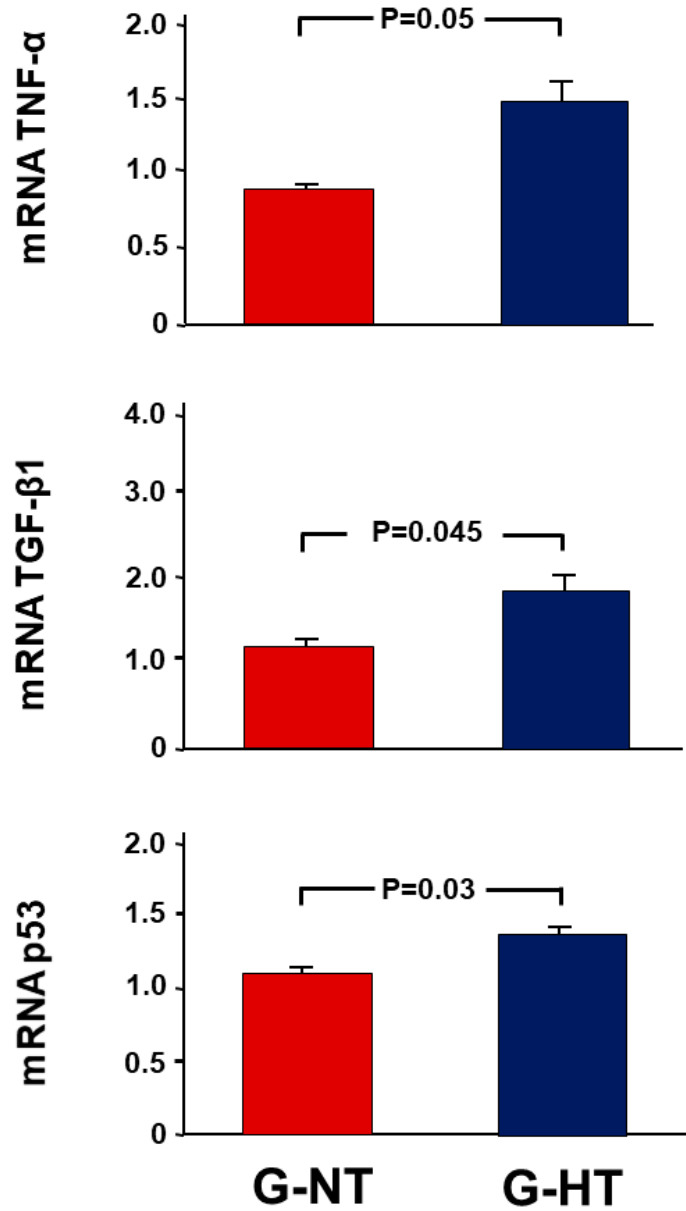
Figure 3. The fold-expression of the gene expression of pro-inflammatory (TNF- α ), pro-fibrotic (TGF- β 1) cytokines and pro-apoptotic gene p53 in the POK (post-obstructed kidney) compared with Figure 3. The fold ‐ expression of the gene expression of pro ‐ inflammatory (TNF ‐α ), pro ‐ fibrotic the NOK (non-obstructed control kidney) within each group. Values represent the mean ± SEM. (TGF ‐β 1) cytokines and pro ‐ apoptotic gene p53 in the POK (post ‐ obstructed kidney) compared with the NOK (non ‐ obstructed control kidney) within each group. Values represent the mean ± SEM. Similarly, there was a 4.57 ± 0.55-fold increase in the expression ratio of procollagen type-1 in the POK vs. NOK in the G-HT compared with only 2.67 ± 0.08 in the G-NT ( p = 0.02) (Figure